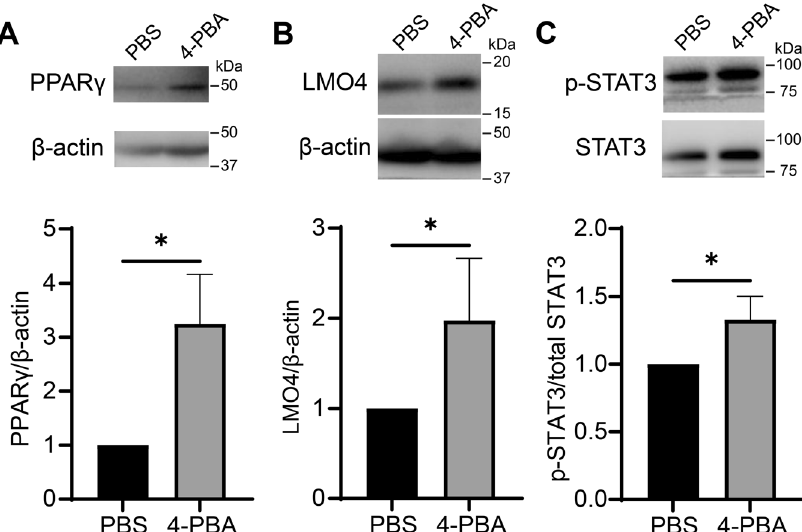
Fig. 4 Induction of resolving signaling molecules PPAR γ , LMO4, and p-STAT3 in neutrophils by 4-PBA. A – C The levels of PPAR γ , LMO4, β -actin, p-STAT3, and total STAT3 of WT neutrophils treated with PBS or 4-PBA (1 mM; 24 hours) were determined by Western blot. Data were representative of at least three independent experiments and are plotted as mean ± SD. * P < 0.05 using Student ’ s t